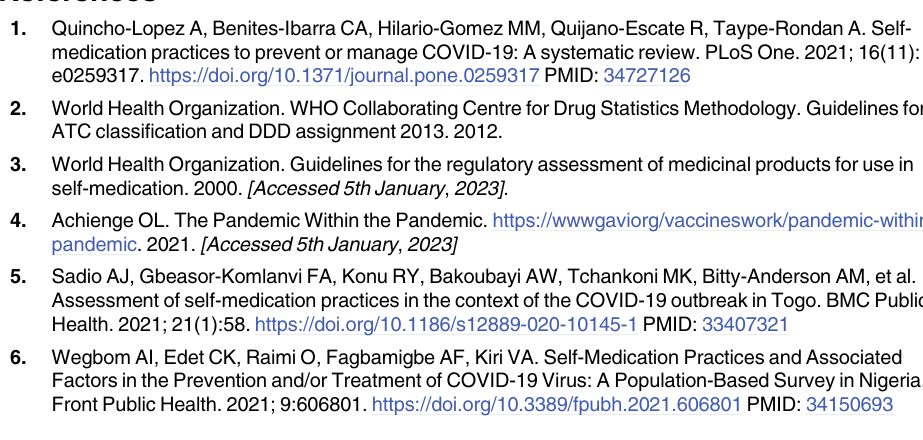
S2 Fig. The black line shows the number of clients purchasing a selected drug before and during the COVID-19 epidemic in Uganda. The COVID-19 era is divided into four periods based on the ascent and descent of the two COVID-19 waves in Uganda. The red line shows the monthly number of COVID-19 cases (see secondary vertical axis) reported during the first two waves in the country. The blue line illustrates the slopes and descents estimated from the negative binomial regression model and their corresponding slopes and